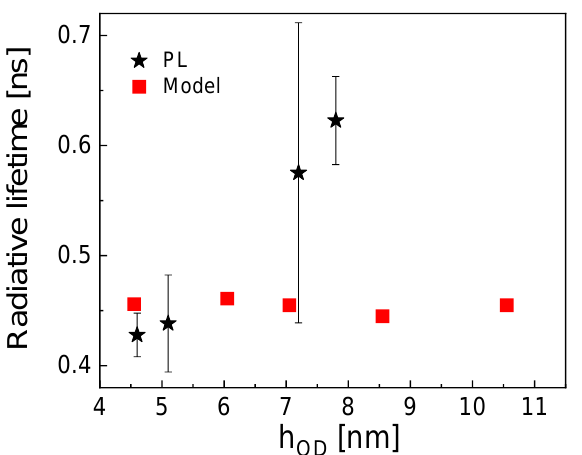
Figure 5. Experimental and simulated radiative lifetimes as a function of the quantum dot